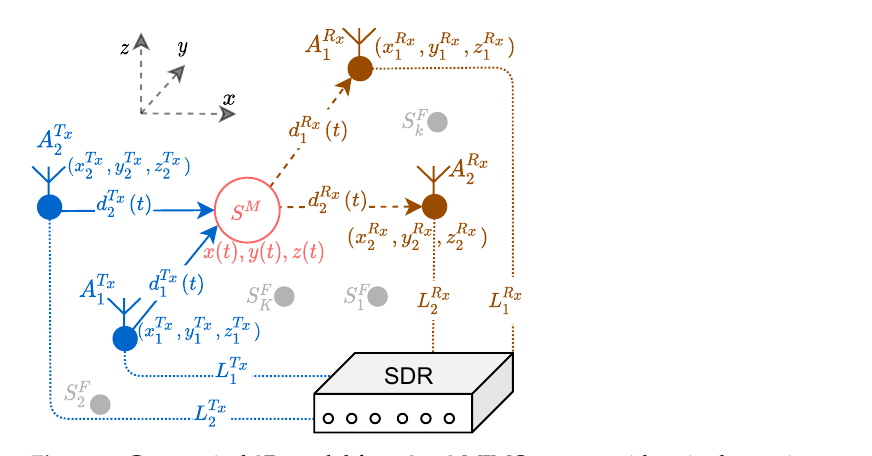
Figure 3. Geometrical 3D model for a 2 × 2 MIMO system with a single moving scatterer S M and K fixed scatterers S F ( k = 1,2, . . . , K k